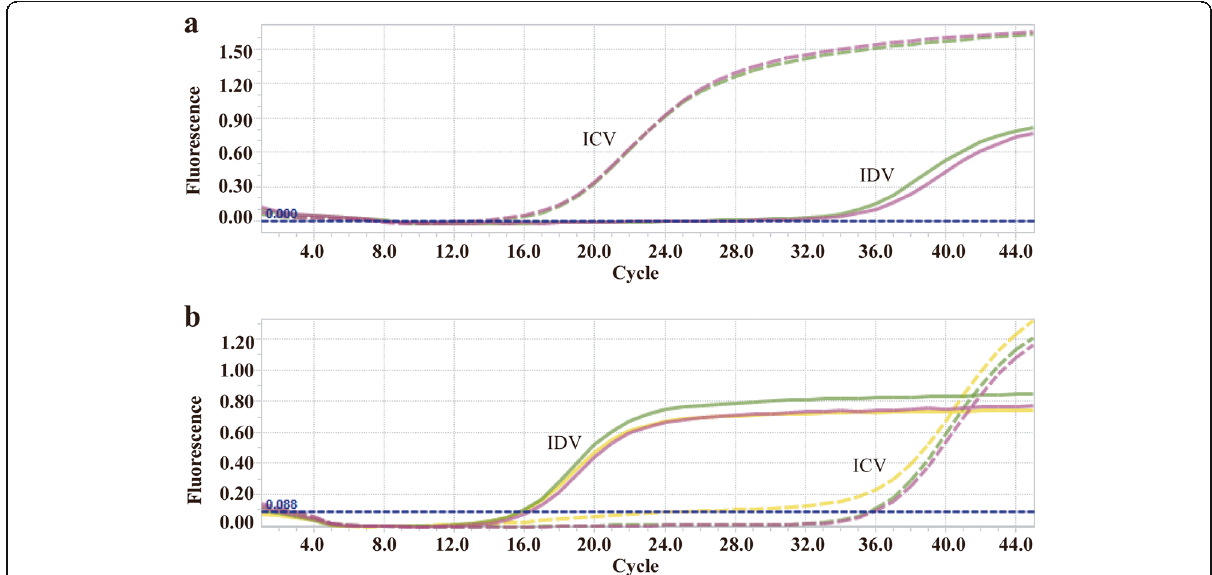
Fig. 4 Coinfection simulation experiments with mixed templates at different concentrations. a Amplification curves of ICV plasmid standard at concentrations of 1 × 10 1 copies/ μ L + IDV plasmid standard at concentrations of 1 × 10 7 copies/ μ L. b Amplification curves of ICV plasmid standard at concentrations of 1 × 10 7 copies/ μ L + IDV plasmid standard at concentrations of 1 × 10 1 copies/ μ